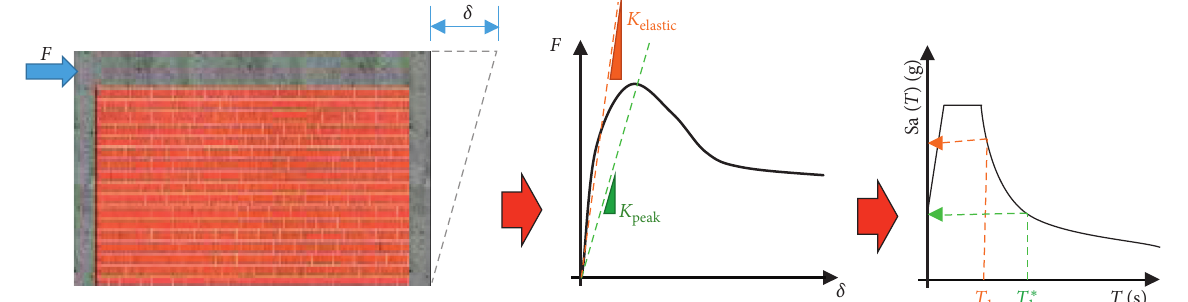
Figure 11: Consequences of nonsuitable assessment of the infill elastic stiffness in the everyday building seismic